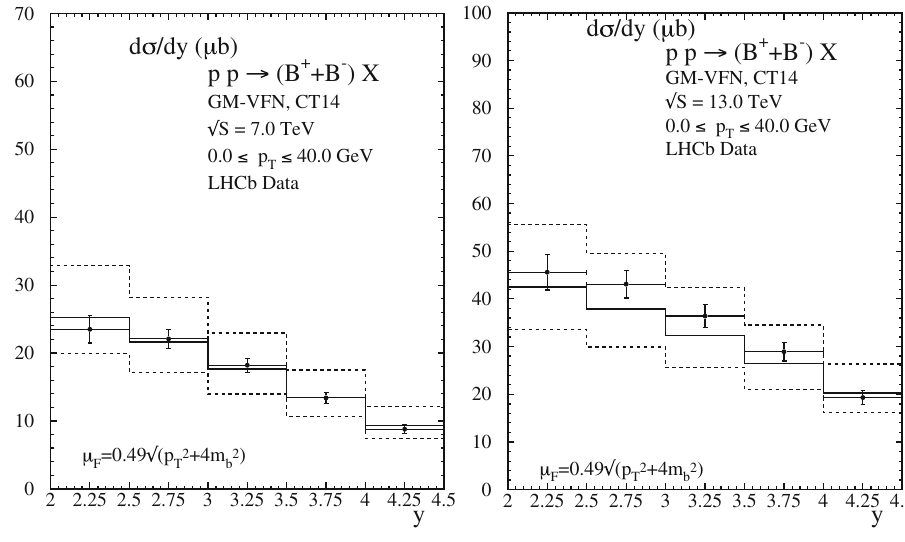
Fig. 5 Ratio of the B ± p T distribution at S = 7 TeV, integrated over y in the range 2 . 0 ≤ y ≤ 4 . 5. The black points represent the measured values from the LHCb Collaboration. Thefull-linehistogramisthepredictionwiththedefaultchoiceofscales usingthePDFsetCT14.Thedashedhistogramsrepresentthetheoretical uncertainties range between 0 . 4